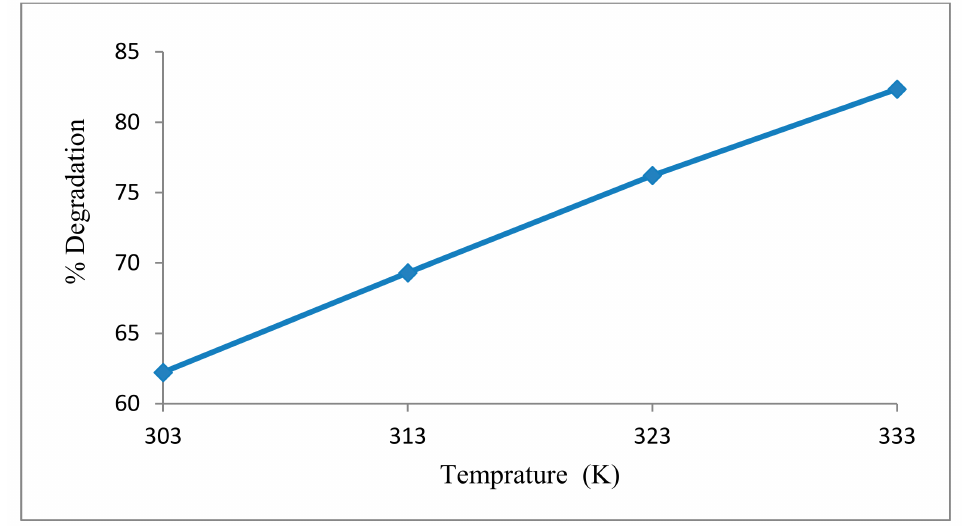
Figure 8. Effect of temperature for % dye degradation by Pd/ZrO 2